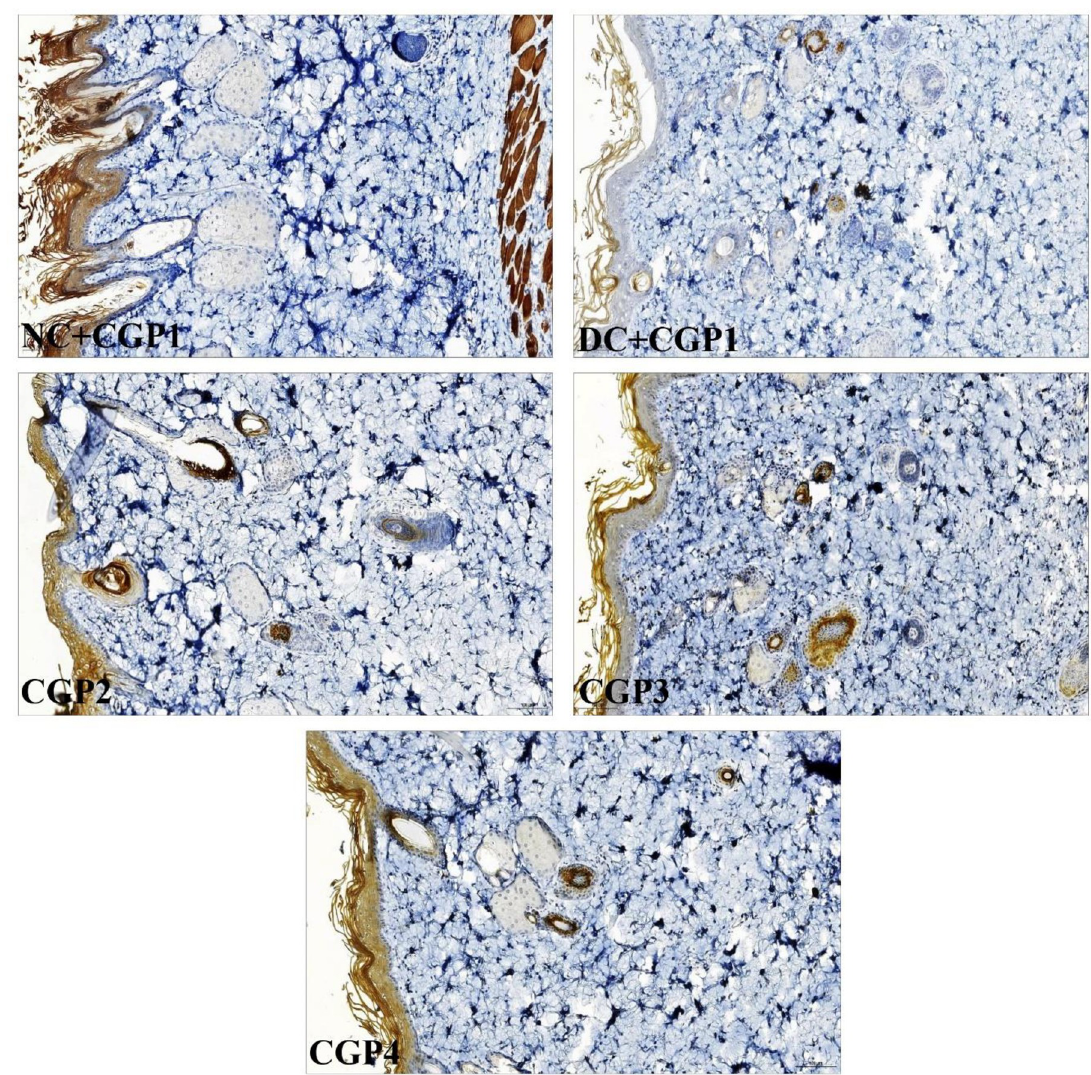
Fig 11. Effect of GC-AgNP CGPs dressing on PCNA in diabetic rats. Immunohistochemistry staining of PCNA (brown color). Red arrows point towards the distribution of PCNA protein in brown color. NC+CGP1: Normal control dressed with blank cotton gauze; DC +CGP1: Diabetic control rats dressed with blank cotton gauze; CGP2: Diabetic rats dressed with 13.06 μ M gallocatechin and silver nanoparticle (GC-AgNP) impregnated cotton gauze patches (DC+ 13.06 μ M CGP2); CGP3: Diabetic rats dressed with 26.12 μ M gallocatechin and silver nanoparticle (GC-AgNP) impregnated cotton gauze patches (DC+ 26.12 μ M CGP3). CGP4: Diabetic rats dressed with silver sulfadiazine (DC+AgS) impregnated cotton gauze patches. Data were expressed as mean ± S.E.M (n = 6). � p < 0.05 compared to control, # p < 0.05 compared to DC. Scale bar = 100 μ